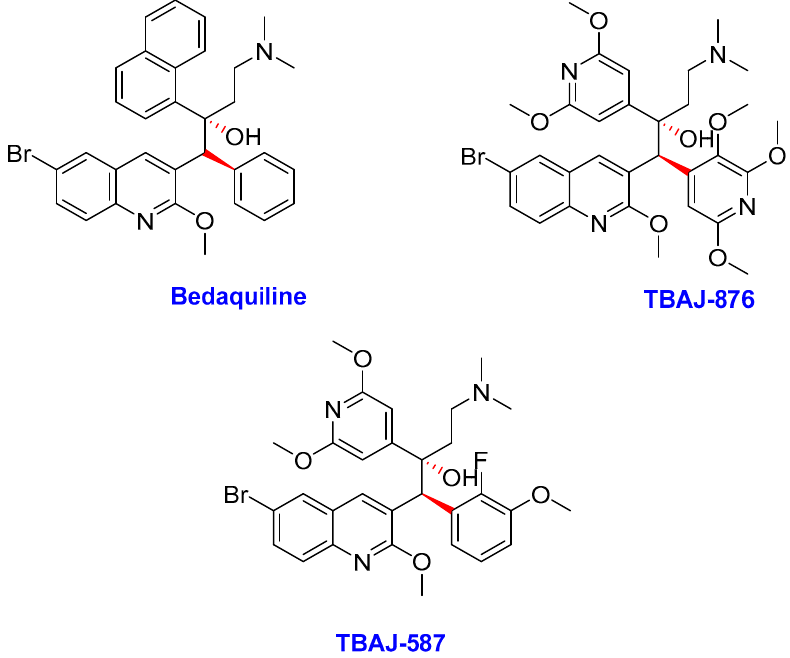
Figure 2. The chemical structures of diarylquinoline analogs in TB clinical